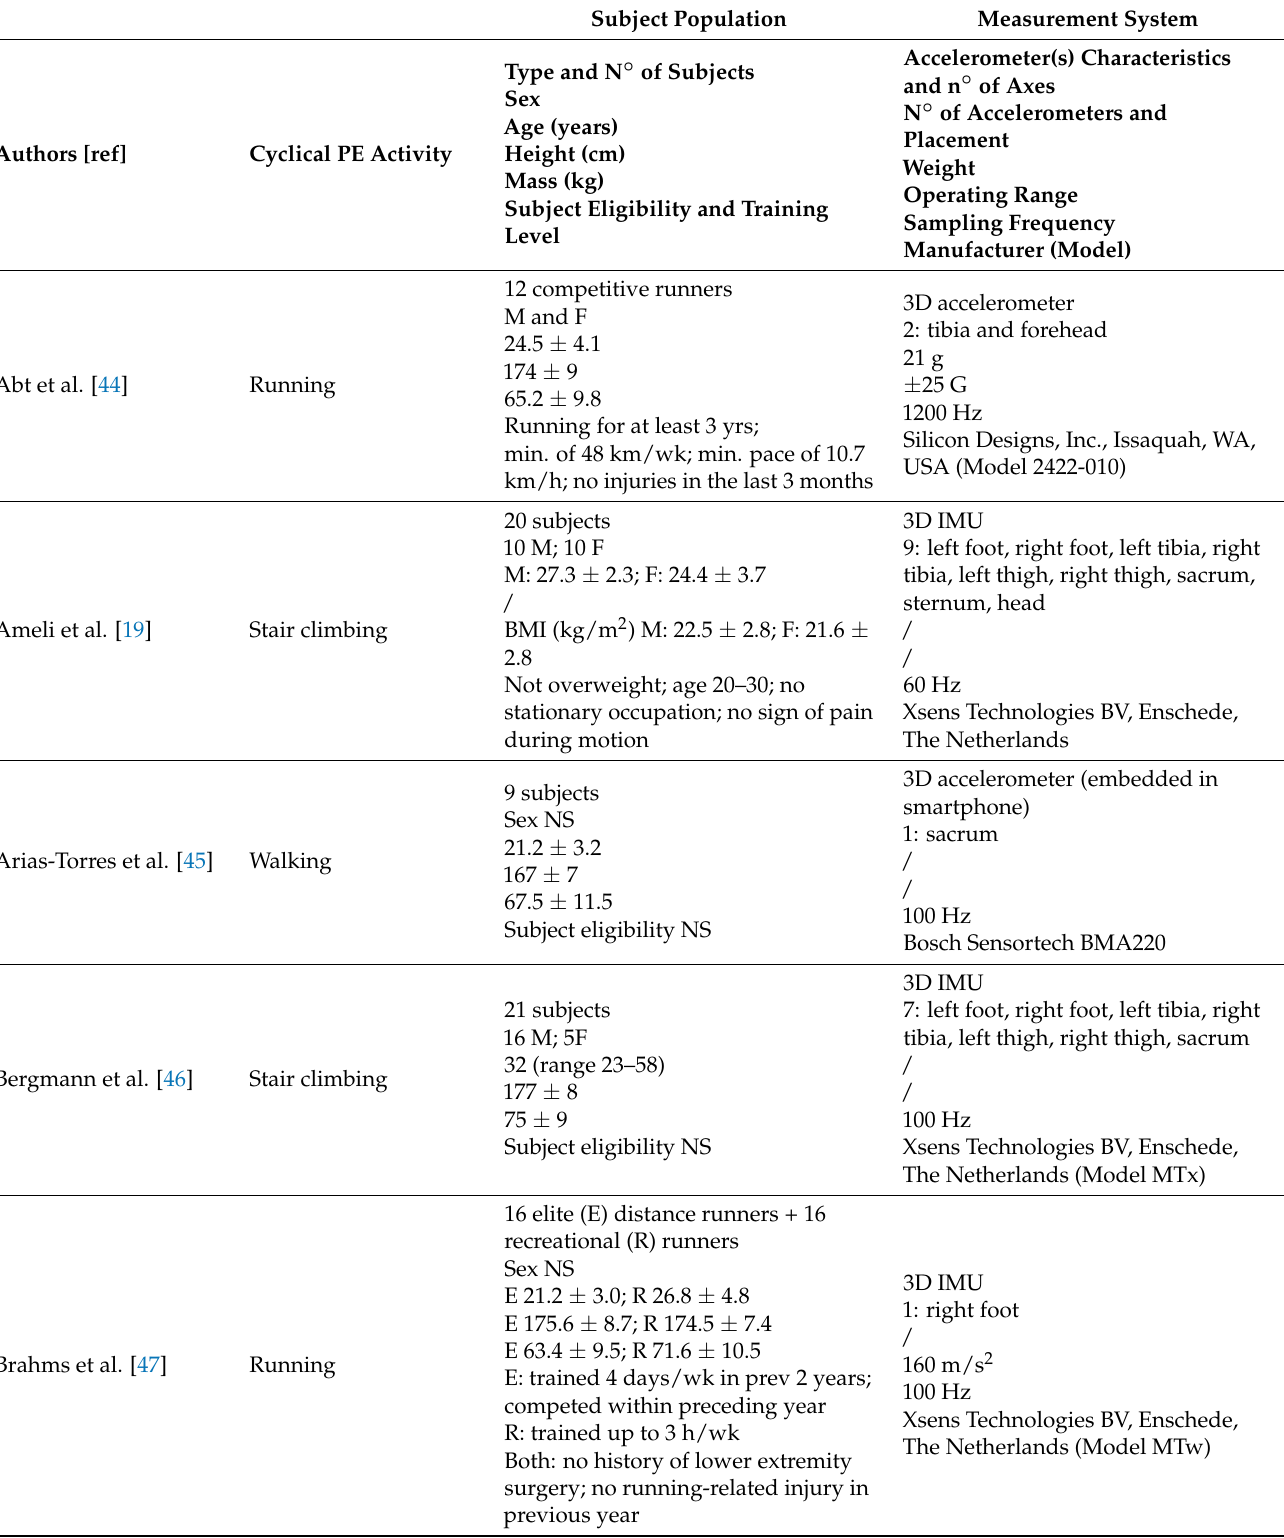
Table 2. Subject population and measurement system